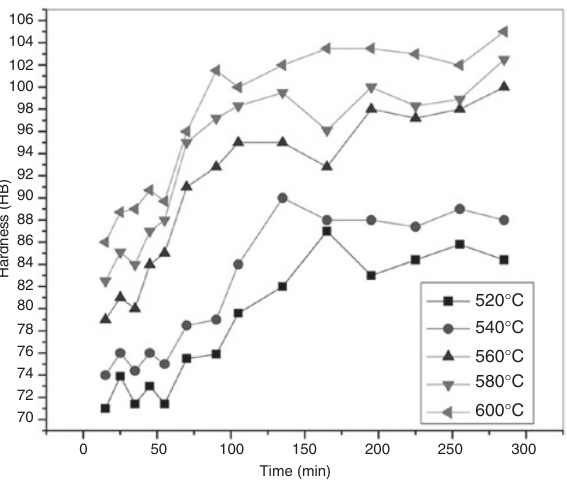
Figure 14 The HB hardness as a function of the aging time for the composite under different sintering